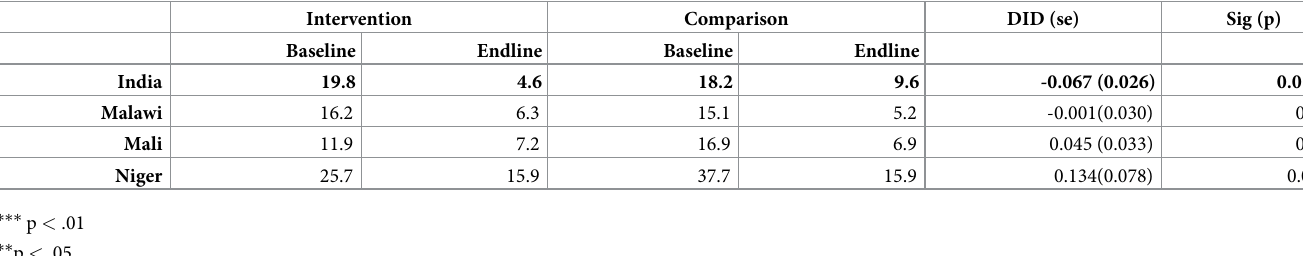
Table 2. Difference-in-differences, proportion of ever married girls ages